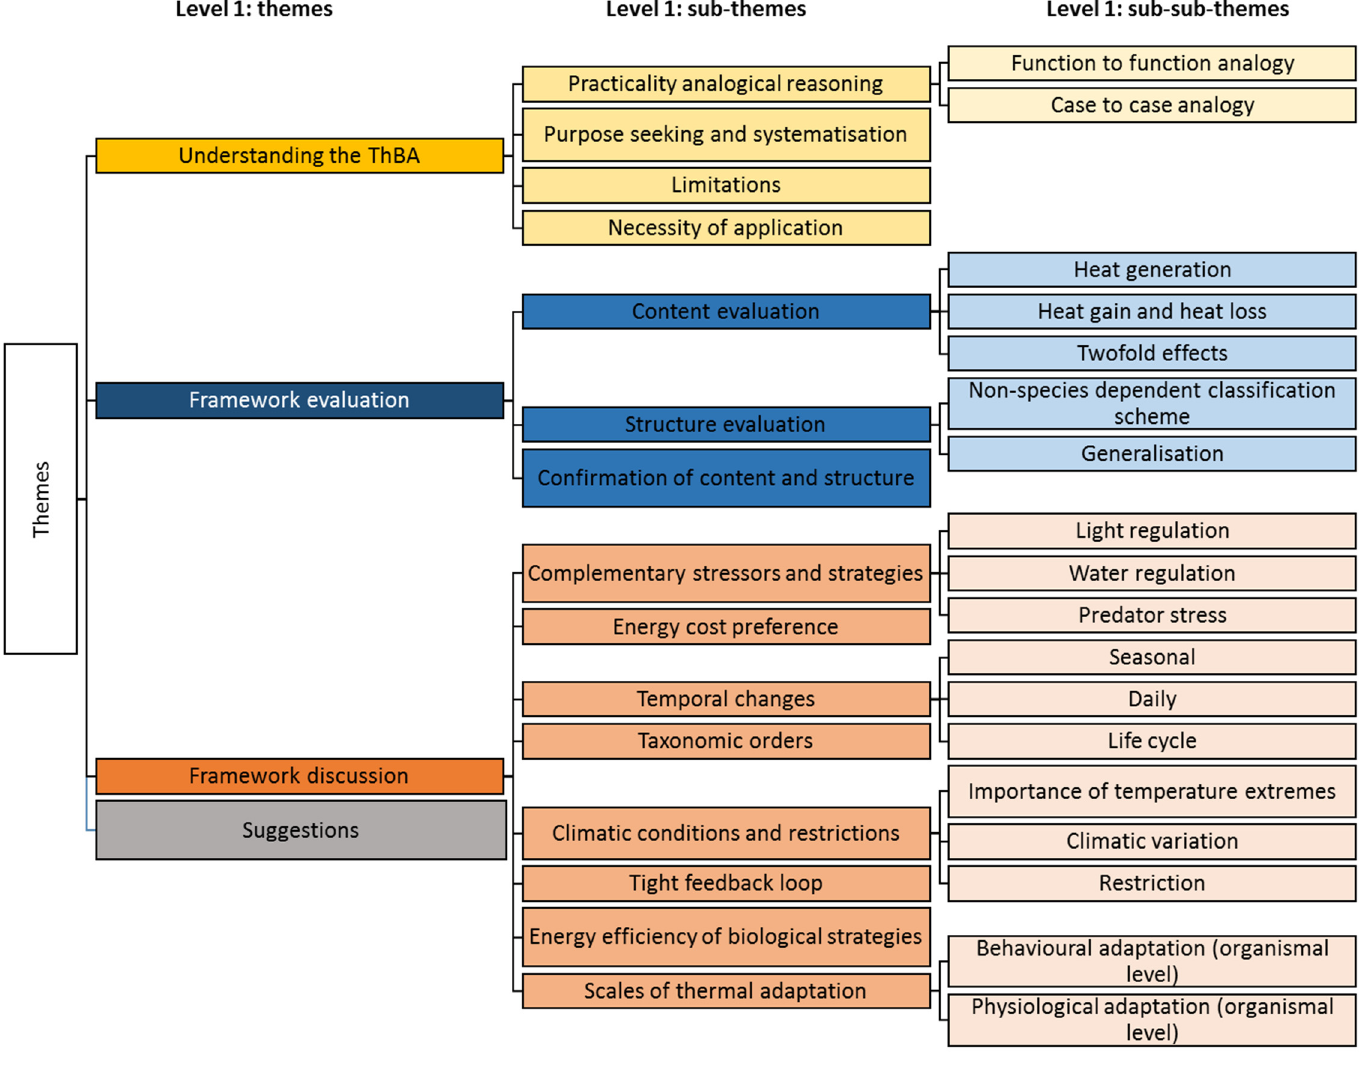
Figure 3. The coding structure including the main emergent themes and sub-themes.